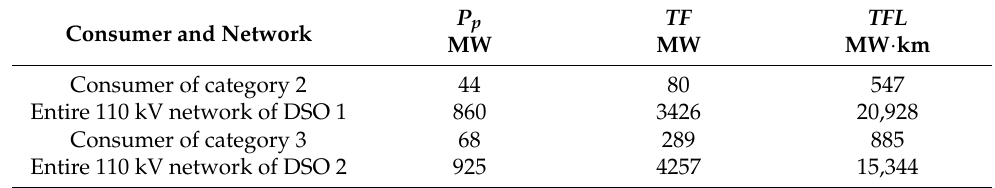
Table 9. The peak power and the degree of network utilization by consumers of categories 2 and 3. Consumer and Network